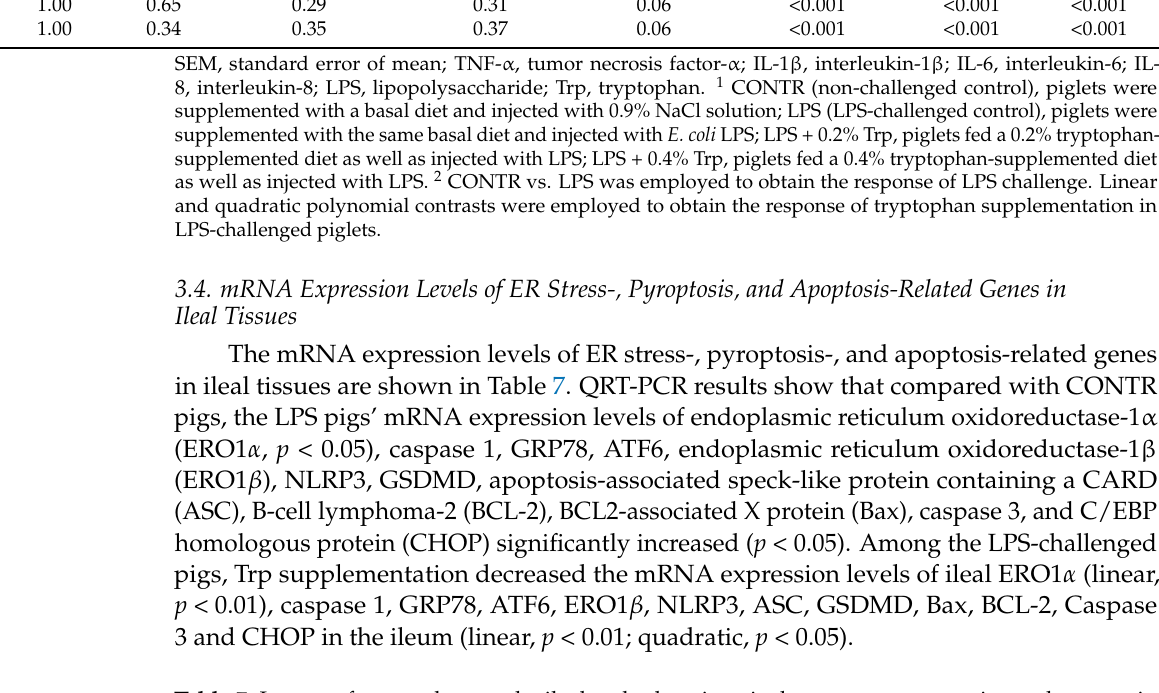
Table 7. Impact of tryptophan on the ileal endoplasmic reticulum stress, pyroptosis-, and apoptosis- related gene expressions after 4 h LPS challenge in